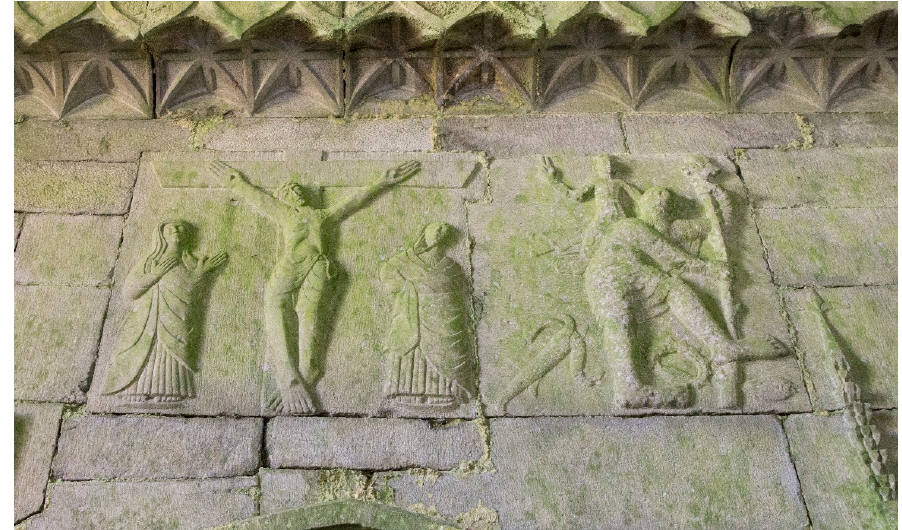
Figure 25. Kilcooley Abbey, Co. Tipperary, fifteenth century. Photograph by the author.